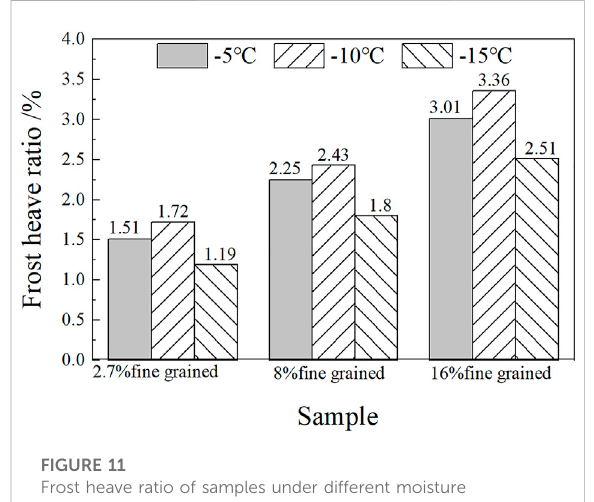
FIGURE 12 Frost heave of samples under different